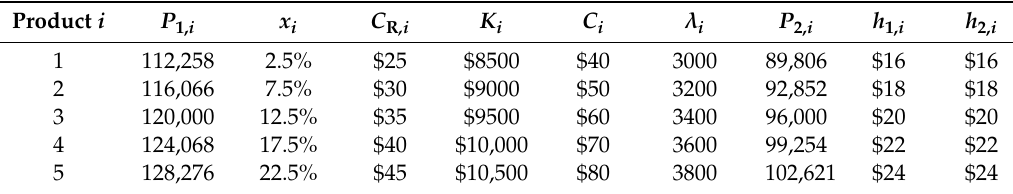
Table 2. The assumed parameters’ values in stage 2.